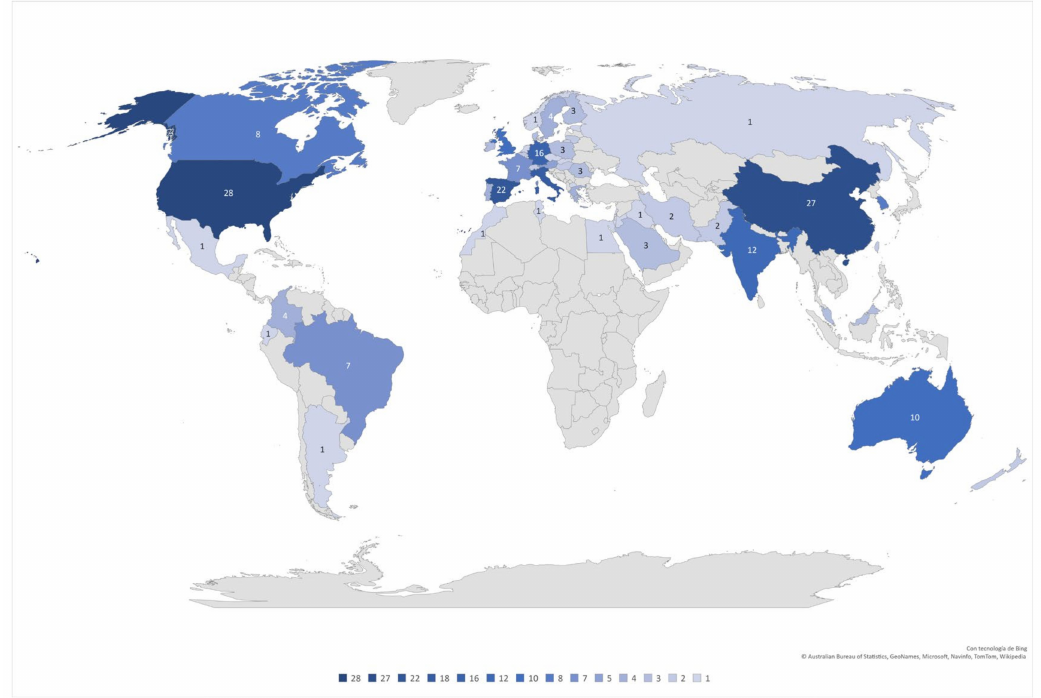
Figure 3. Geographical distribution and density of